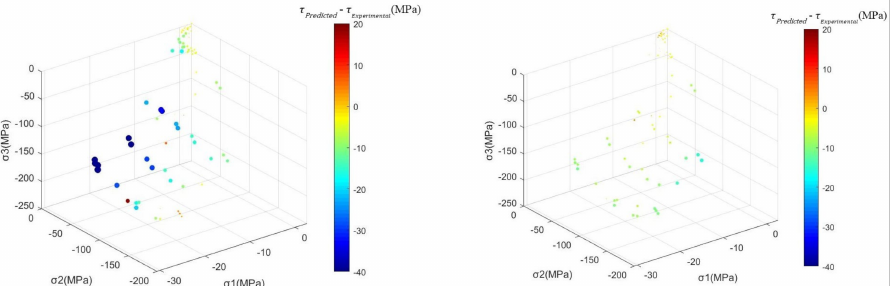
Figure 6. The error of D-P ( left ) and B-P ( right ) criterion.